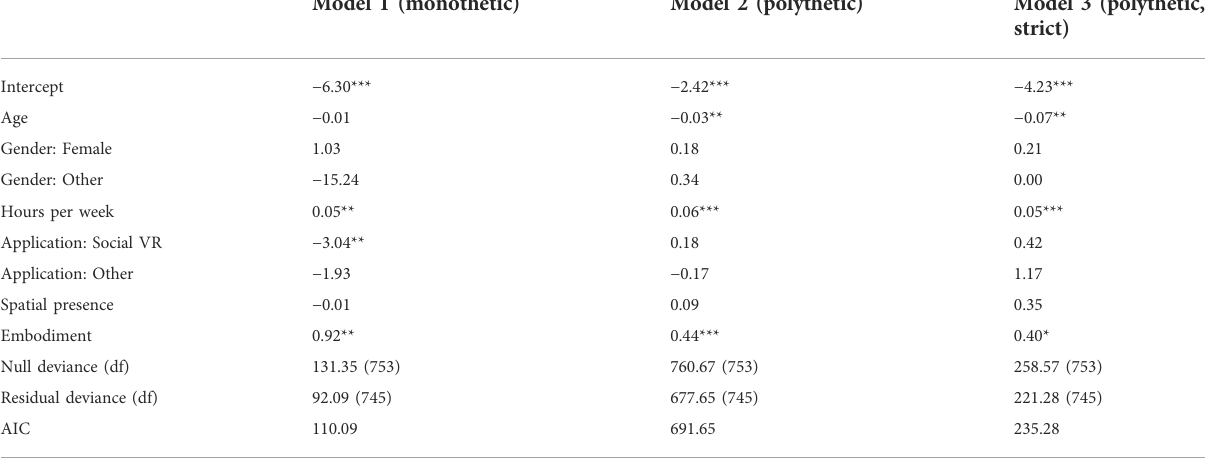
TABLE 2 Summary of the binomial logistic regression models (log odds ratios). Model 1